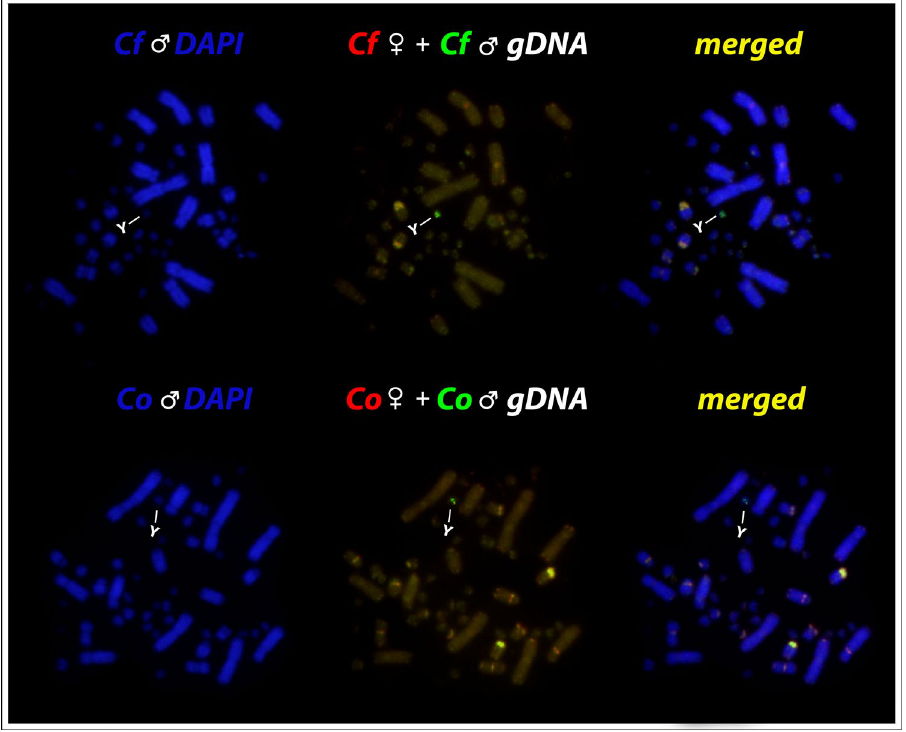
Figure 9. Chromosome spreads of Chelus fimbriata (Cf) and Chelus orinocensis (Co) males after CGH procedures using male (green) and female-derived (red) genomic probes. The common genomic regions are highlighted in yellow. Please note in green the male specific sequences Y-linked on a tiny mic (lines).